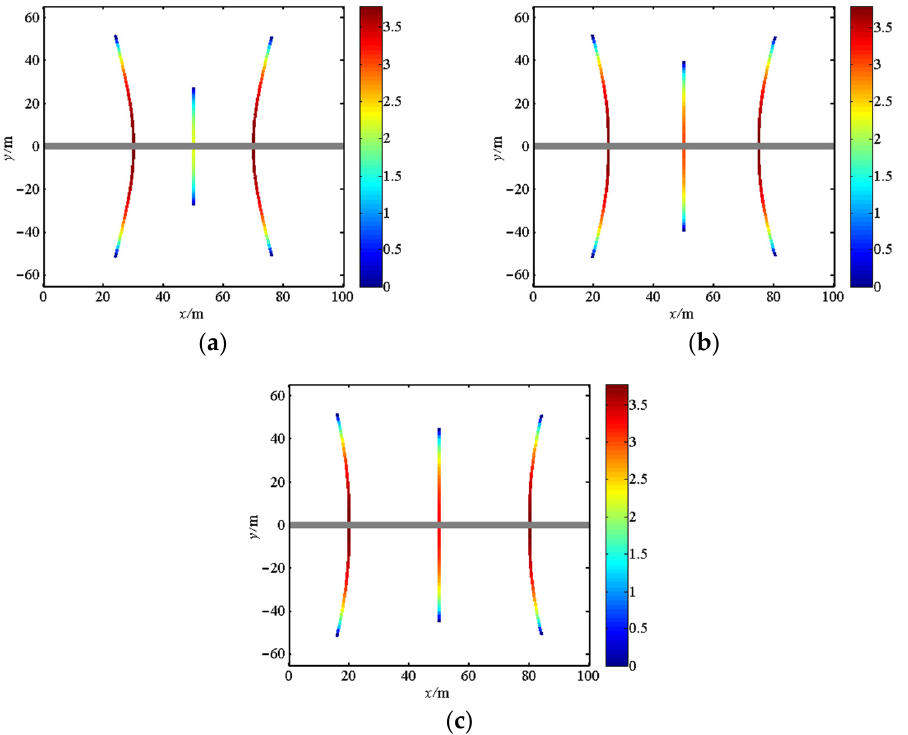
Figure 5. Fracture propagation path and fracture width distribution (mm) with different cluster